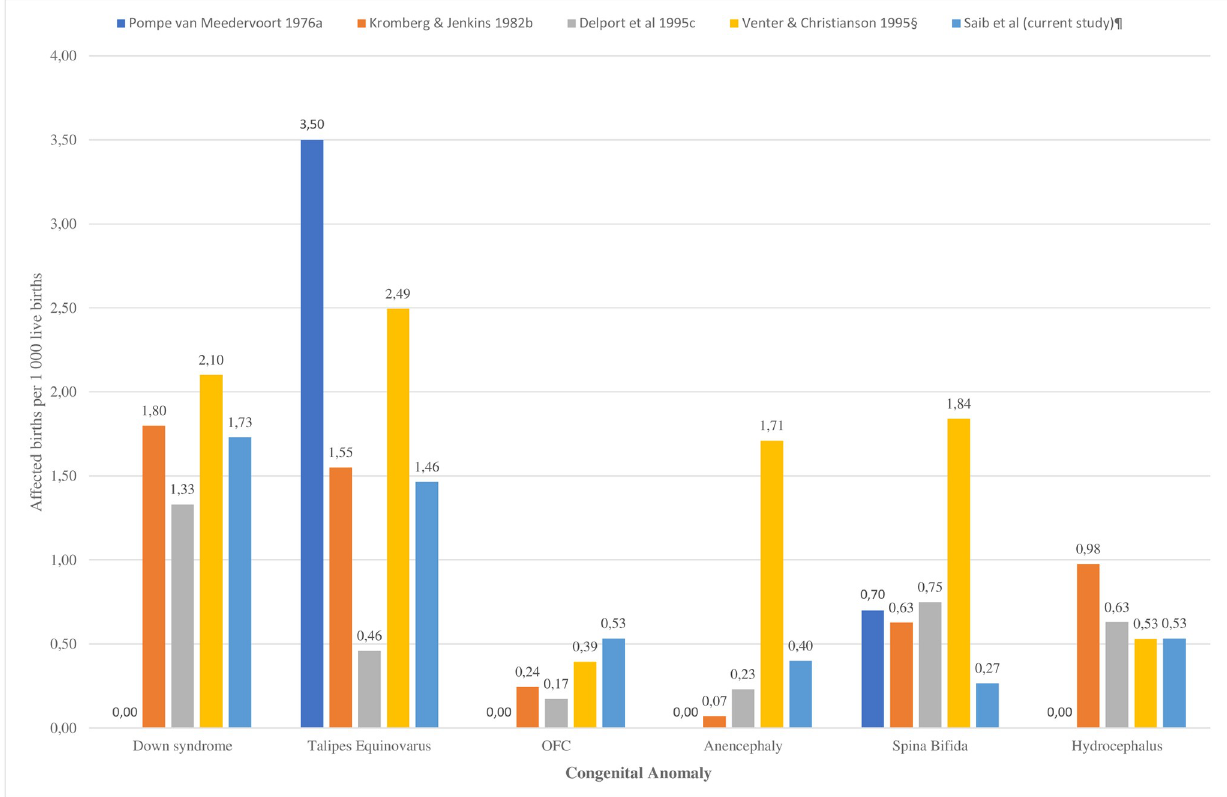
Fig 1. Comparison of birth prevalence rates for key congenital anomalies from the current study with rates observed by other facility-based studies in South Africa. a Pompe van Meedervoort 1976: Prospective,75% urban hospital-based study (Pelonomi Hospital, Bloemfontein, Free State), 10 000 live births over 3 years [23]. b Kromberg & Jenkins 1982: Retrospective, urban hospital-based study (Chris Hani Baragwanath Hospital, Johannesburg, Gauteng), 28 689 live births over 2 years (1976 to 1977) [24]. c Delport et al 1995: Prospective, urban hospital-based study (Kalafong Hospital, Pretoria, Gauteng), 17 351 live births over 3 years (1986 to 1989) [25]. d Venter & Christianson 1995: Prospective, rural, hospital-based (Mankweng Hospital, Limpopo), 7 617 live births over 3.5 years (1989 to 1992) [26]. e Saib et al 2021: Retrospective, predominantly urban, hospital-based (Edendale Hospital, Pietermaritzburg, KwaZulu Natal), 7 516 live births over one year (2018, current study).